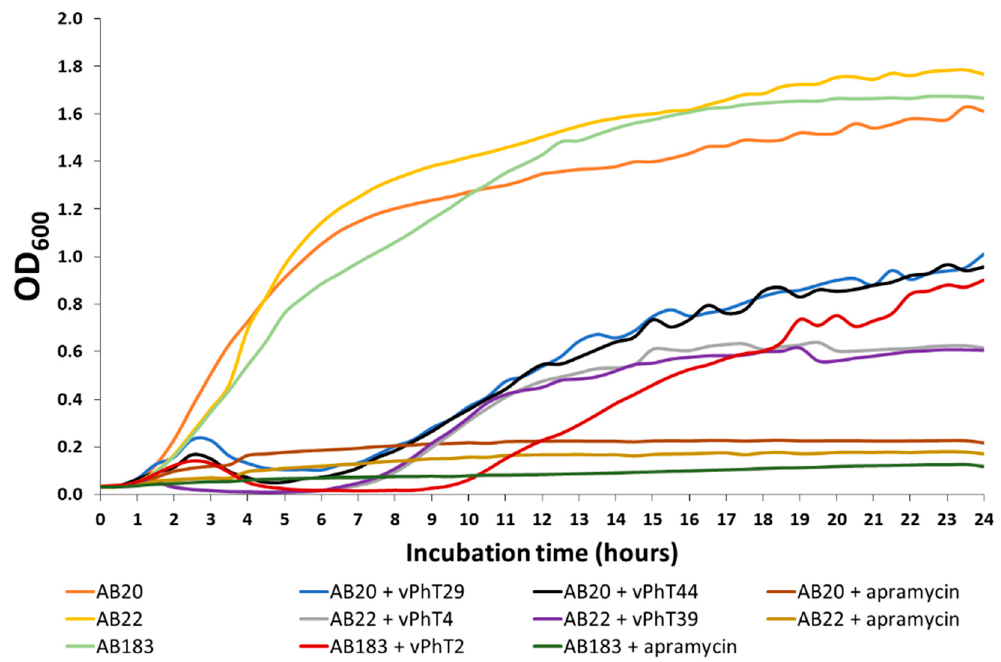
Figure 2. Twenty-four-hour growth curve for Acinetobacter baumannii strains grown with and without bacteriophages or apramycin (500 µg/mL). Data displayed as OD 600 (N=3).